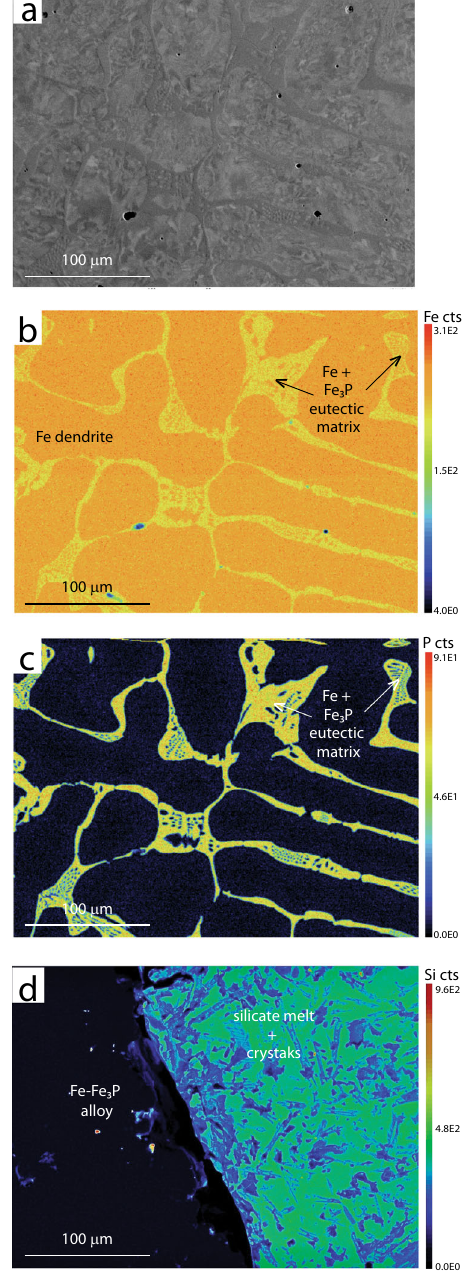
Fig. 6 Metallic fl ow micro-textures. a BSE image of the metallic fl ow silicon map of the metallic (left)-silicate (right) fl ow